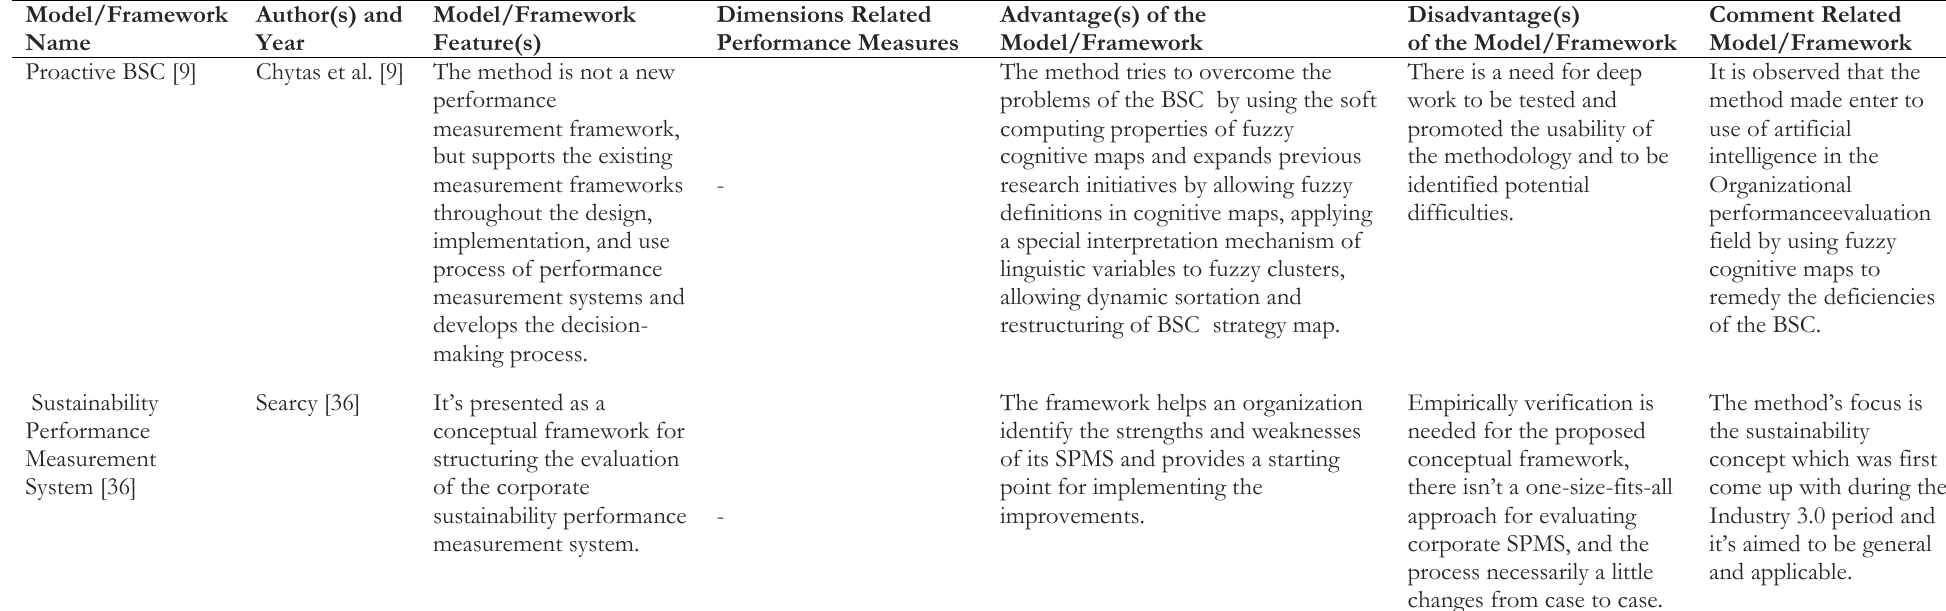
Table 13. Organizational performance measurement models developed in Industry